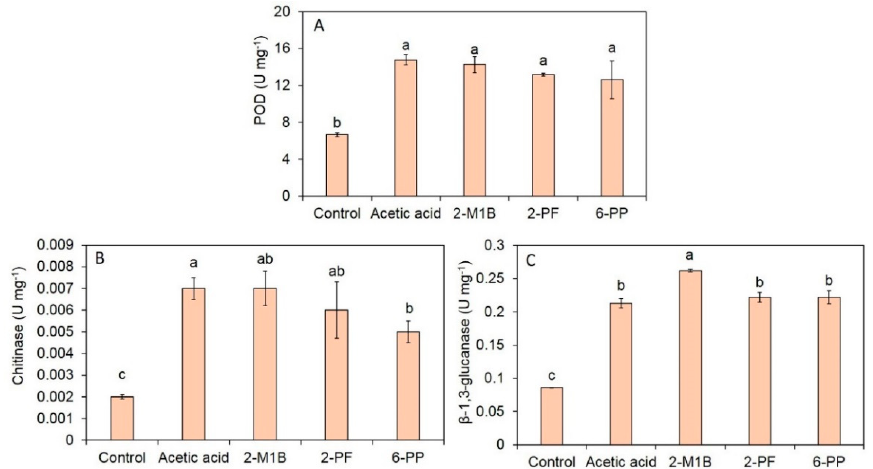
Figure 8. Activities of the defense-related enzymes peroxidase ( A ) and cell wall-degrading enzymes chitinase ( B ) and β -1,3-glucanase ( C ) between the control and VOC-treated A . thaliana. Different letters indicate statistically significant differences among treatments ( p < 0.05) using the Tukey’s test. The effects of each commercial volatile compound on the plant phenotype (fresh weight and root length) in A. thaliana are shown in Figure 9. The results show no statistically significant differences among the treated and untreated samples (Figure 9).